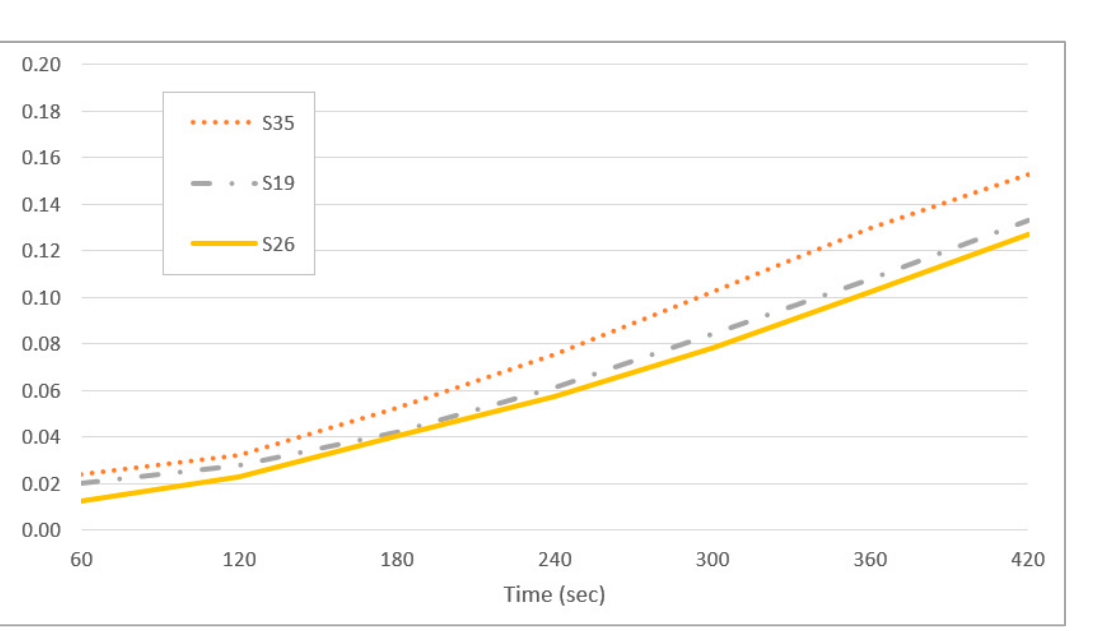
Figure 8. Weight loss as a function of time of sample S35, S19, and S26.